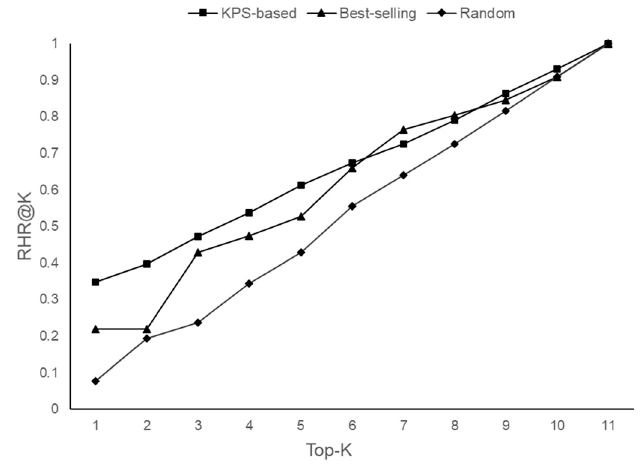
Figure 10. The performance evaluation of recommender systems for the new users.